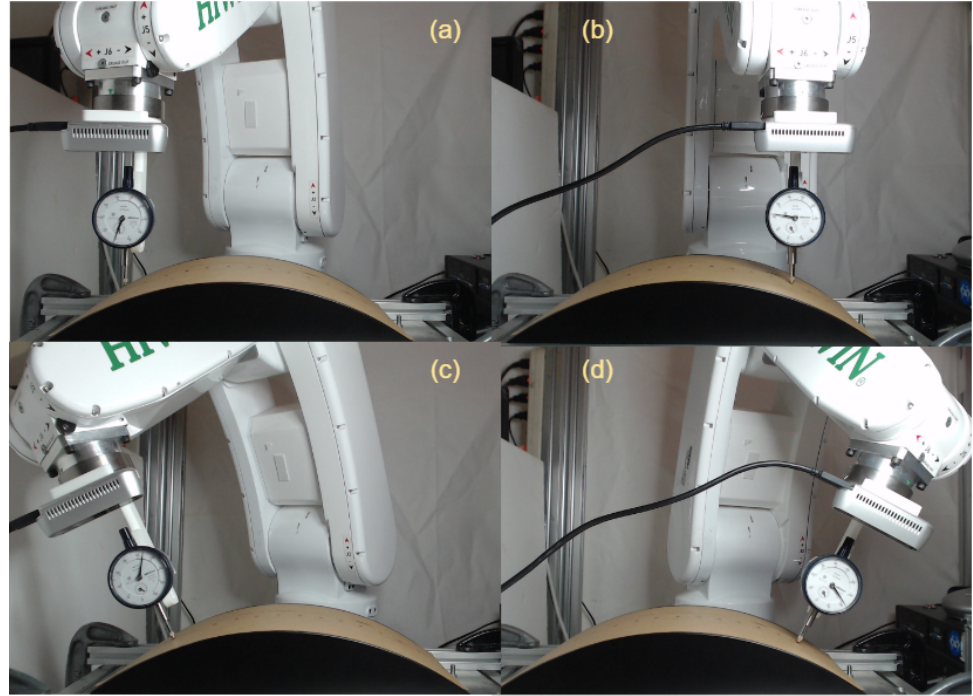
Figure 12. Experiments on curved surface. ( a , b ) Demonstrate incorrect robot poses where the end- effector is not perpendicular to the surface, while ( c , d ) Showcase the corrected poses where the end-effector is perpendicular to the